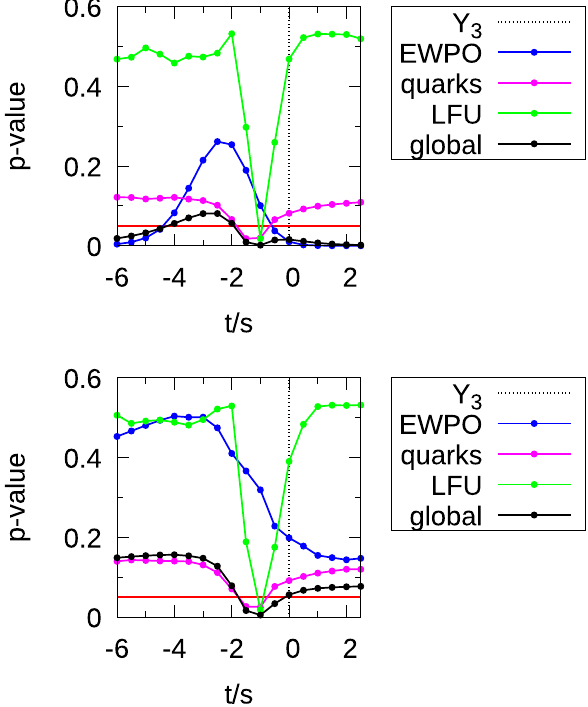
Fig. 1 p values for different models depending upon t / s , for n = 3. The top panel includes the recent CDF measurement of M W as in (1.1), whereas in the bottom panel, the default smelli2.3.2 constraint (i.e. excluding the recent CDF measurement) on M W was used as in (4.13). The Third Family Hypercharge Model is marked in the legend by Y 3 . Only the global p value accounts for the 2 fitted parameters in the calculation of the number of degrees of freedom. We consider global p values above the red line at 0.05 to be acceptable fits to the